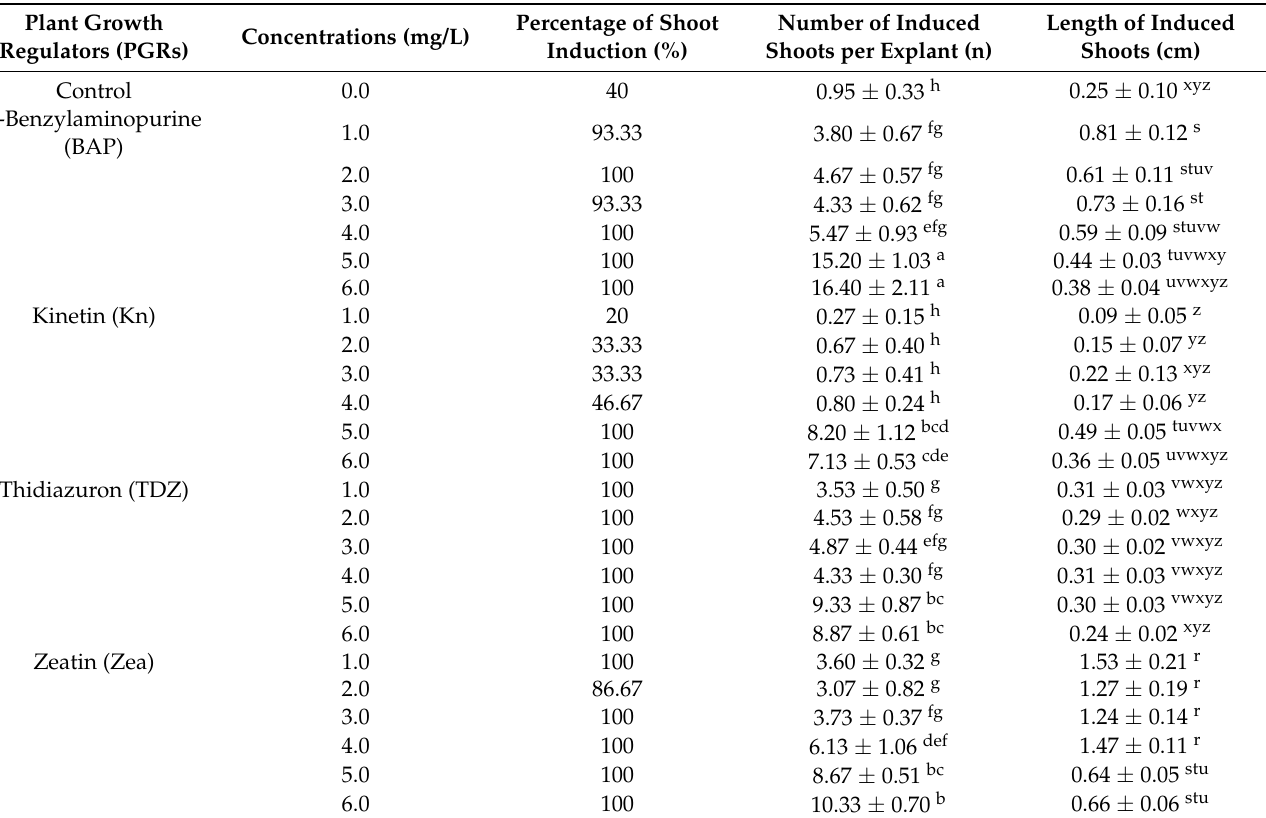
Table 1. The effects of different concentrations of plant growth regulators on shoot regeneration after 6 weeks of